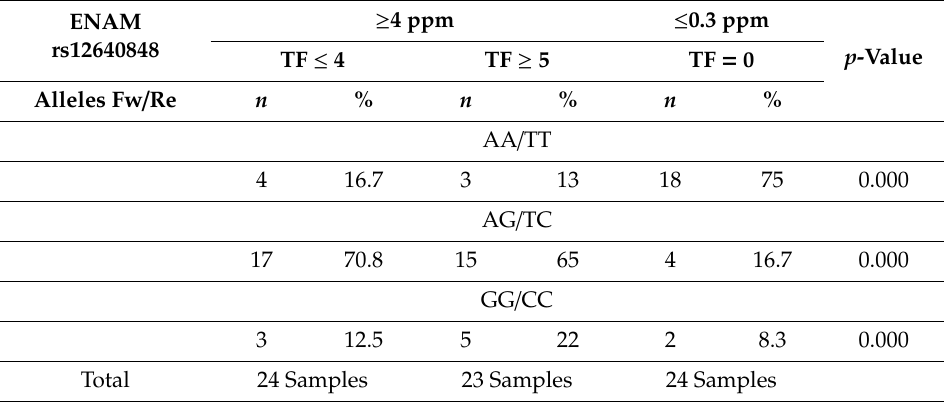
Table 2. Distribution of number and percentage of alleles by groups according to di ff erent exposure of fluoride concentrations.